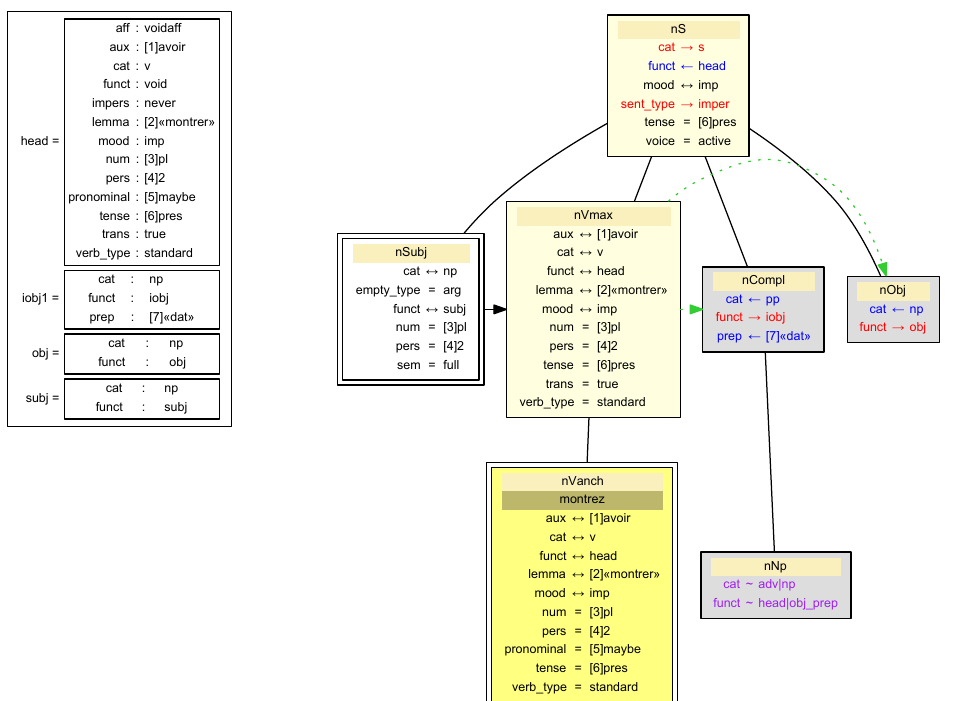
Figure 14: Anchored EPTD for the verb montrez